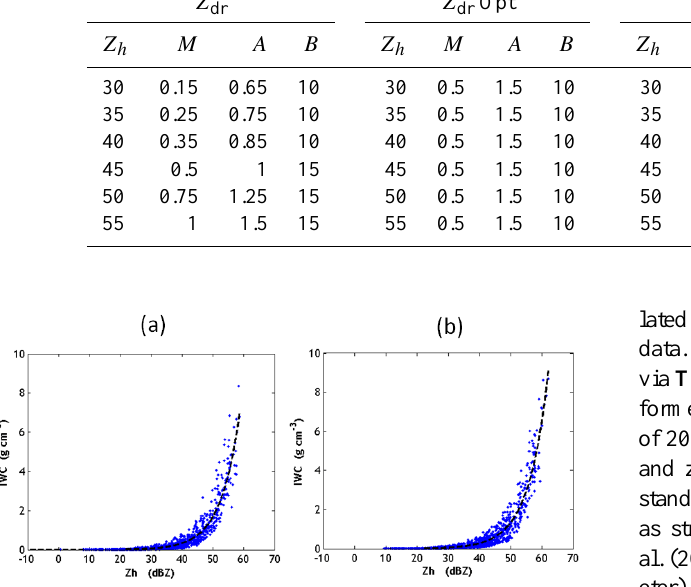
Figure 2. Scatter plots of C-band radar reflectivity and IWC g . The left panel refers to spheroidal shape and the right panel to conical shape of graupel. Exponential fits (Eq. 2) are shown by black dashed